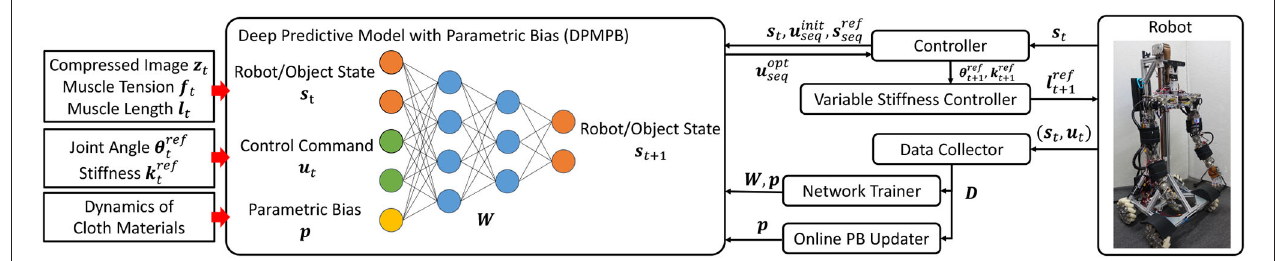
FIGURE 2 | The overview of our system: deep predictive model with parametric bias (DPMPB), controller using DPMPB for dynamic cloth manipulation, variable stiffness controller for musculoskeletal humanoids, data collector for DPMPB, and online updater of parametric bias